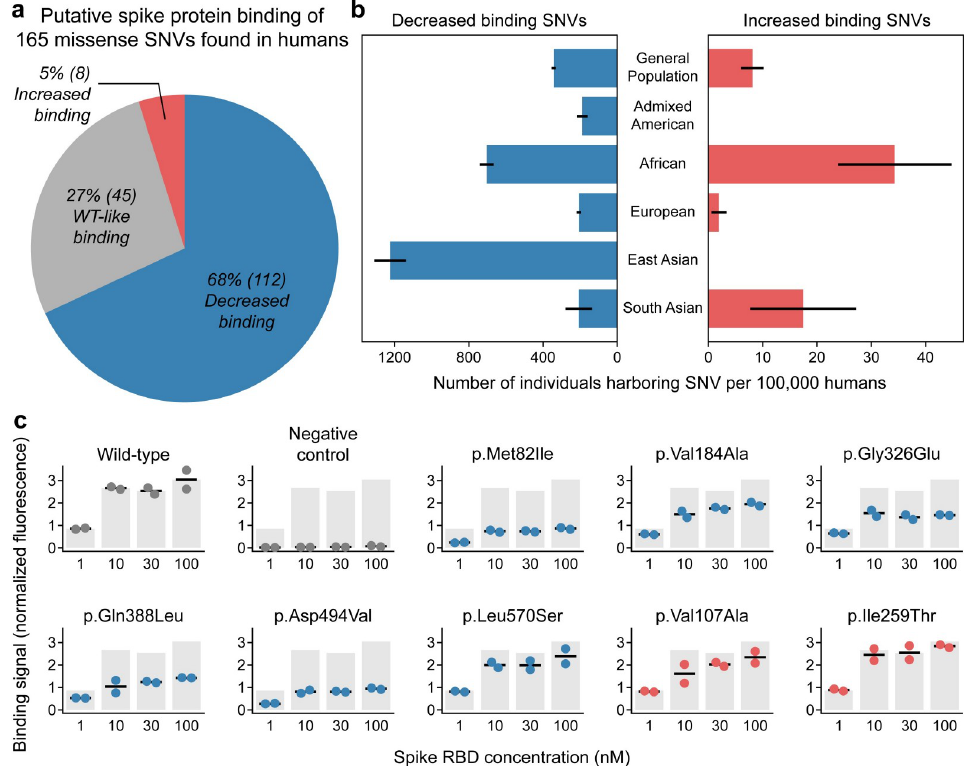
Fig 2. Functional annotation of human missense SNVs. (a) Our large-scale mutagenesis data encompasses 165 missense SNVs found in the human population. We assign putative spike protein binding annotations to these variants. Roughly two-thirds display decreased spike binding, one-third display binding similar to wild-type ACE2, and a small fraction display increased binding. (b) We estimate 320–365 individuals per 100,000 humans may harbor SNVs that decrease spike binding, while 4–12 individuals may have SNVs that increase binding. Specific human subpopulations possess higher and lower frequencies of SNVs that alter spike binding. Error bars represent one standard deviation and were generated by applying bootstrap statistical analysis to the SNV allele count data. (c) Data for YSD-based binding characterization of eight missense SNVs. The binding signal is defined as mean fluorescence for yeast-displayed ACE2 spike binding divided by mean fluorescence corresponding to ACE2 display level on the yeast surface (S4 and S5 Figs). This normalization is applied to prevent potential differences in ACE2 display from biasing assessment of spike binding. SNVs with negative mutation effect values appear as blue dots, while SNVs with positive mutation effects are shown in red. Each dot represents an experimental replicate at varying spike protein concentrations. The grey bars show wild-type ACE2’s binding signal to serve as a